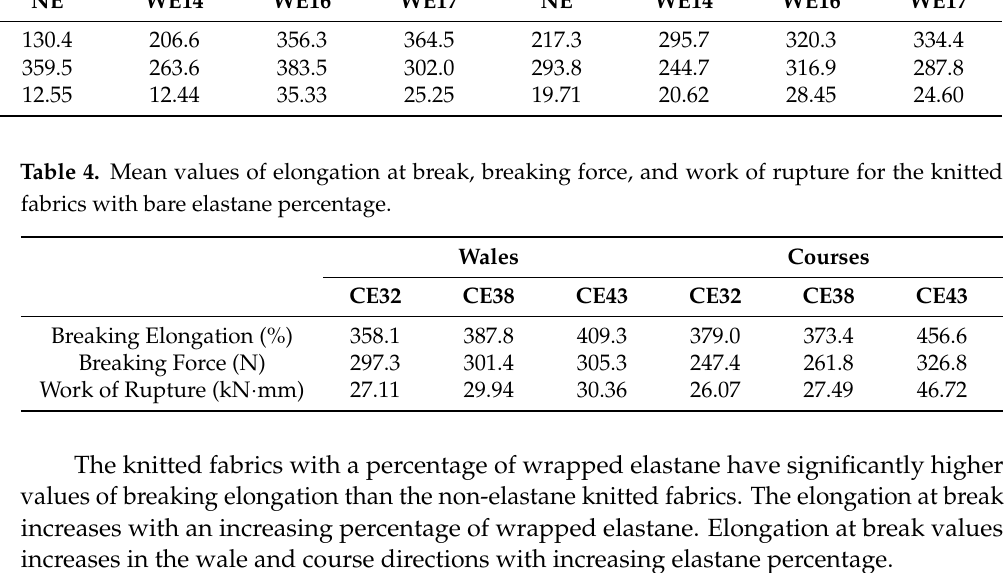
Figure 6. Force–elongation diagrams for knitted fabric samples with bare elastane: ( a ) wales direction; ( b ) courses direction.